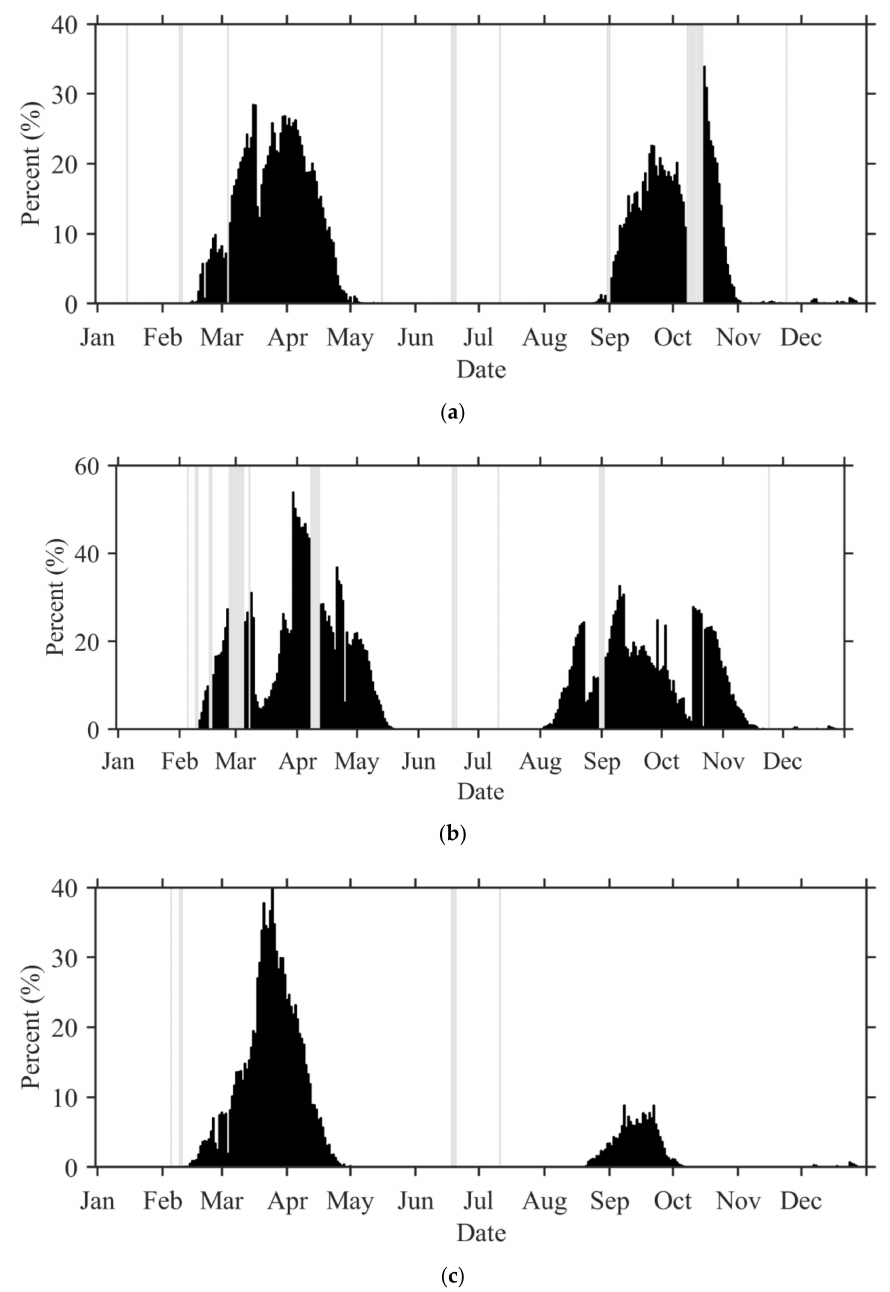
Figure 4. Time series of the number of AGRI pixels with observed band–8 brightness temperatures greater than 300 K during ( a ) 1600, ( b ) 1700, and ( c ) 1800 UTC for each day in 2019, respectively, as a percentage of the total number of pixels of the current time period. The gray bars in the figure indicate missing observations. Only pixels with a satellite zenith angle less than 60 ◦ and that were over the ocean were used. Note that no pixels with solar zenith angles less than 90 ◦ were observed at these